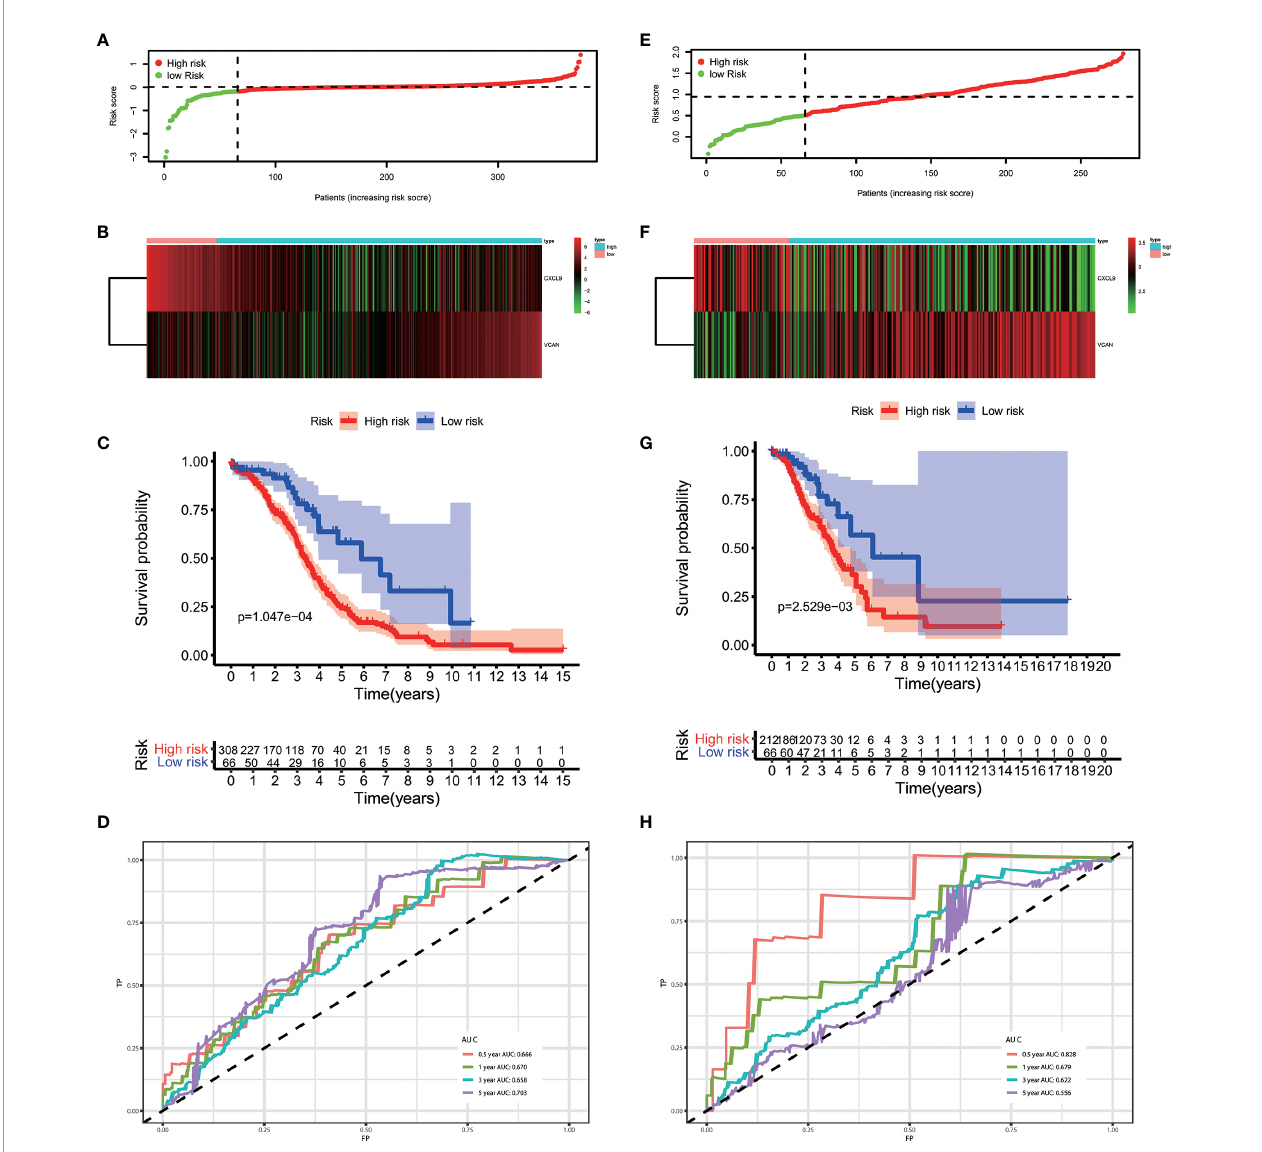
FIGURE 4 | The performance of our IPM in TCGA and GEO cohort. (A, E) Rank of risk score and distribution of groups. (B, F) The expression of included genes, CXCL9 and VCAN. (C, G) Survival curve of risk score. Patients with a higher risk score had a higher overall survival than their counterparts. (D, H) The time independent